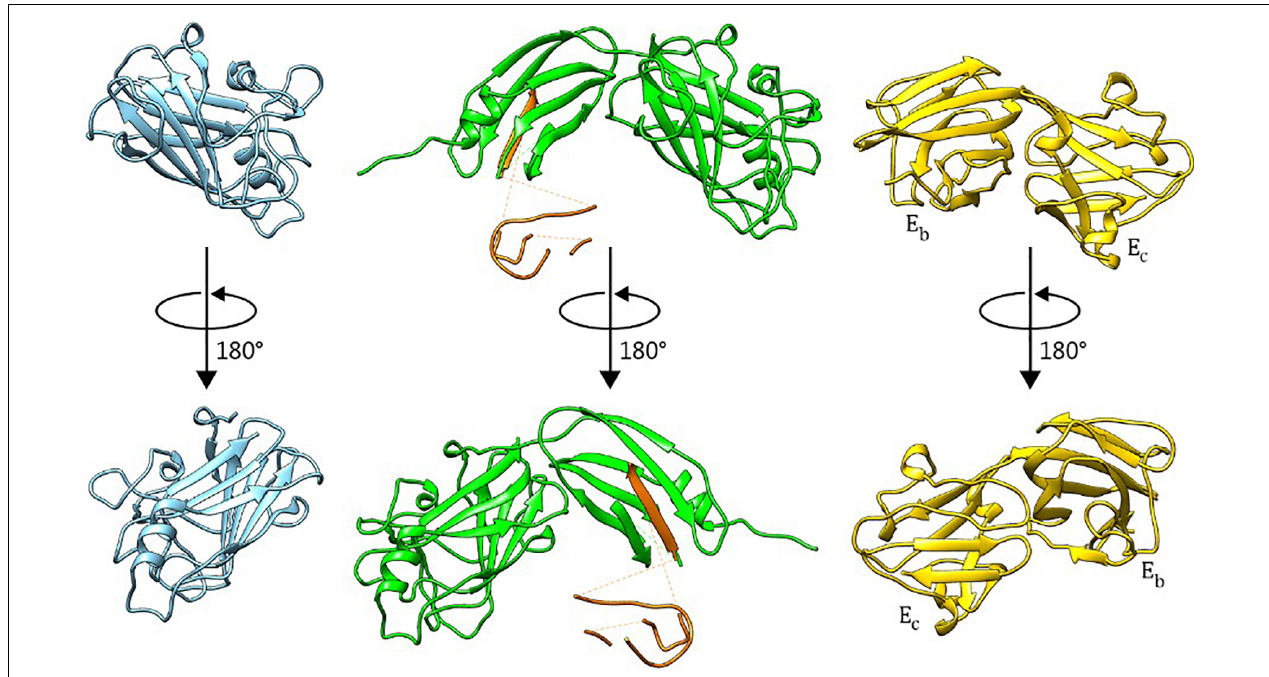
FIGURE 2 | Crystal Structures of BT2857C, BT3158, and BT3700. BT2857C is depicted in blue, BT3158 in green, and BT3700 (RCSB: 4FCH) in yellow. Polyalanine residues used to model sections of the backbone in DUF4959 and DUF5126 of BT3158 are colored orange and left for reference with regards to the positioning of this